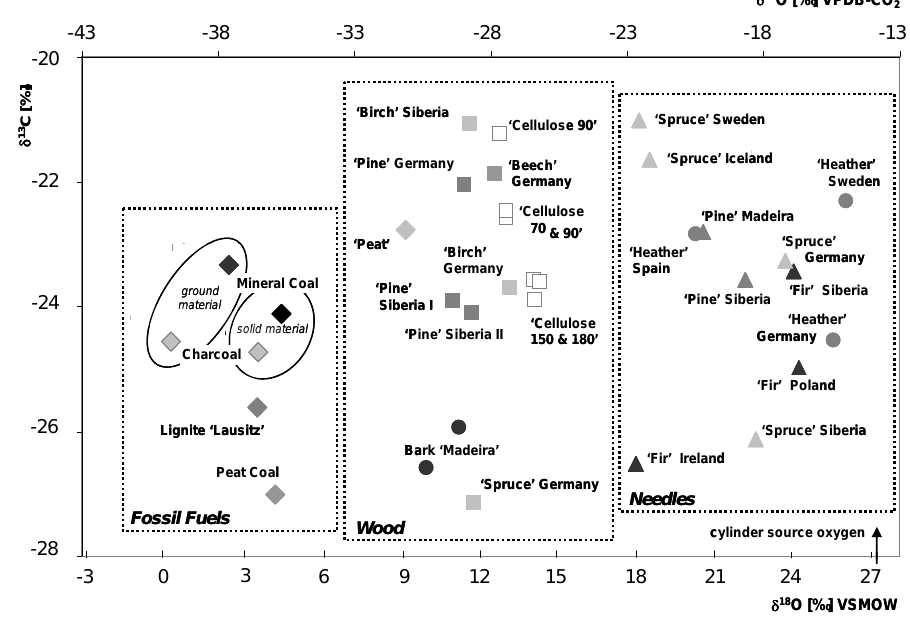
Fig. 3. Isotopic signature of combustion-derived CO 2 from various kinds of fuels of different spatial origin. Triangles indicate needle material, squares wood material, diamonds fossil fuels, the varied species are additionally marked by different hues. The numbers stated beside the cellulose samples refer to the amount of supported oxygen (see for details text section “environmental conditions”).